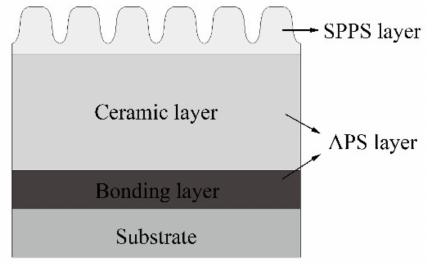
Figure 1. Schematic diagram of coating